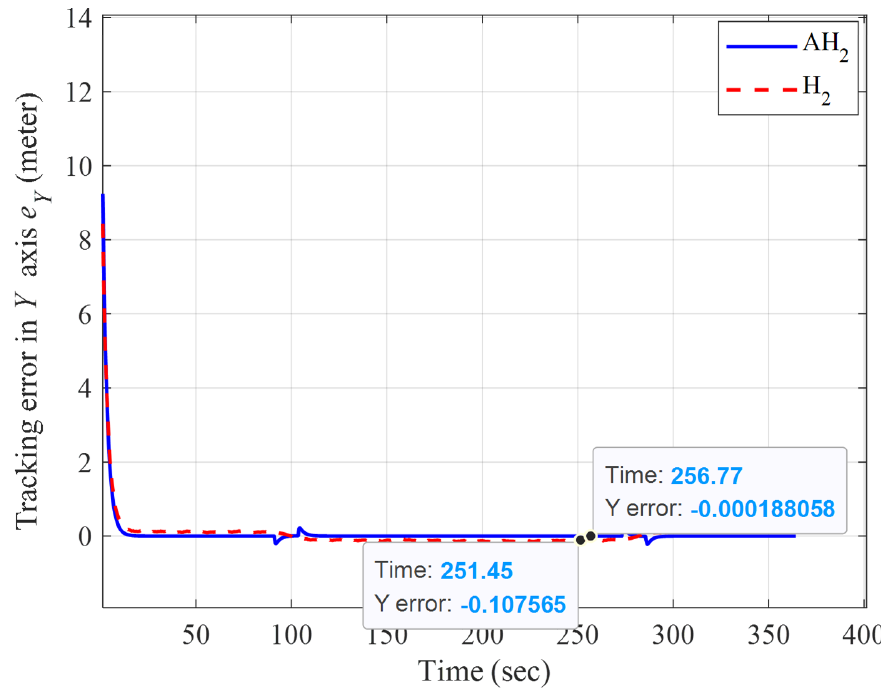
Figure 9. The square trajectory tracking error result of the adaptive H 2 closed-form and H 2 closed- form control approaches for the y -axis from x p = − 7 m, y p = 7 m.